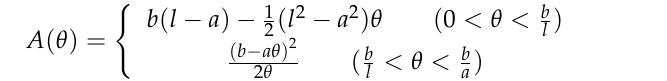
Figure 2. Schematic diagram of the cross-section of the electrostatic spring consisting of comb electrodes.